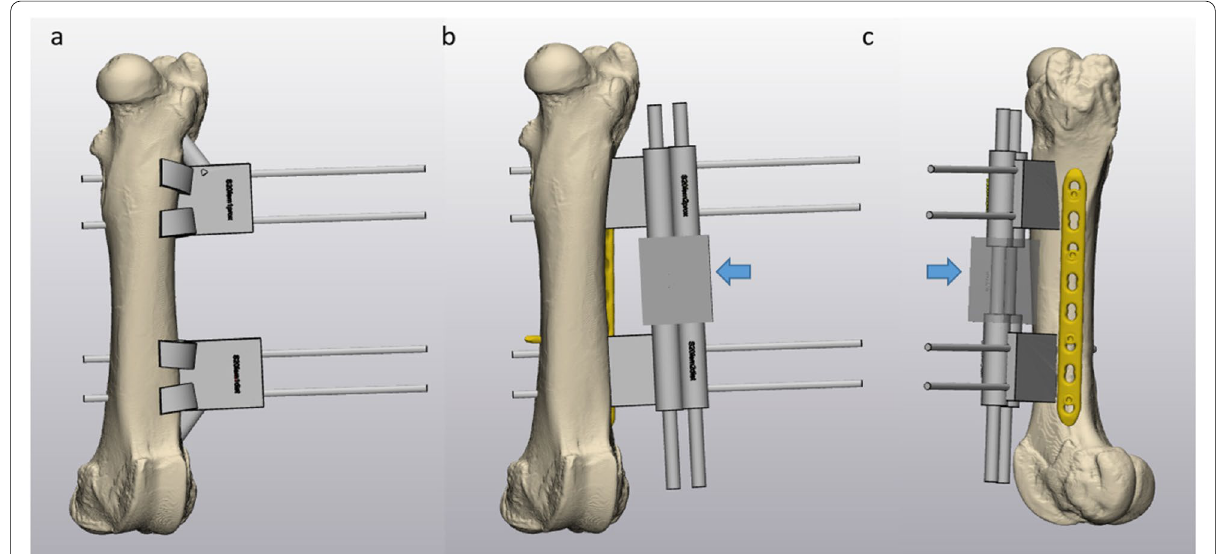
Fig. 1 Femoral surgical guide planning with Materialise 3-matic software. a shows the first step guides with additional “feet” to allow proper bone contact and high accuracy in anteromedial view. Drill pins are inserted through these guides and define the fragment in space. Second step connection guides were slid over these drill pins consecutively. They were slimmer and allowed plate placement, as displayed anteromedial view ( b ) and lateral view ( c ). To connect the proximal and distal second step guide, a reduction/connection guide was used in-between (blue